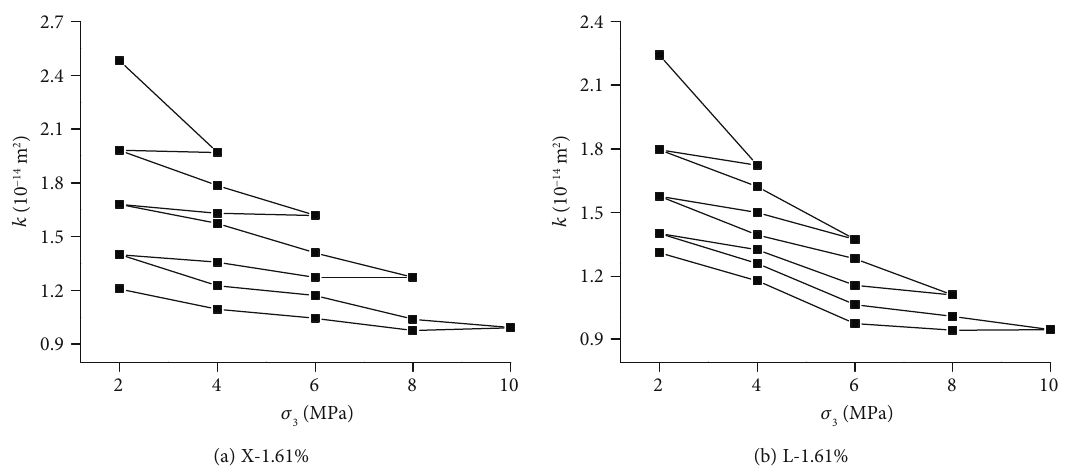
Figure 15: The permeability evolution during the loading-unloading process with the axial strain 1.61%.